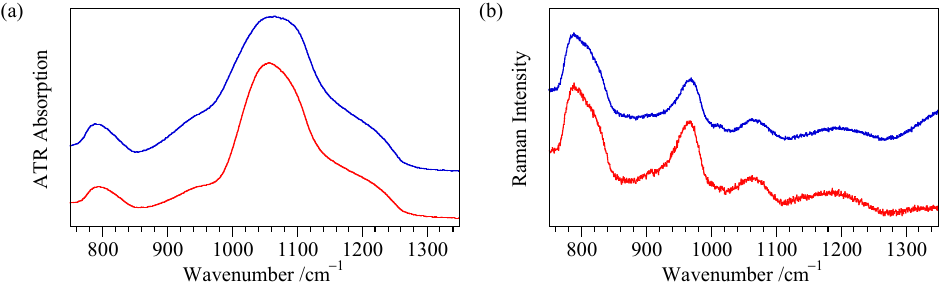
Figure 18. Comparison of ( a ) powder ATR IR and ( b ) Raman spectra for a hydrophane opal from Dubnik, Slovakia (G34475) showing minor differences in the presumed silanol region between dull opaque (red) and translucent (blue) zones. Spectra are scaled and offset for convenience.